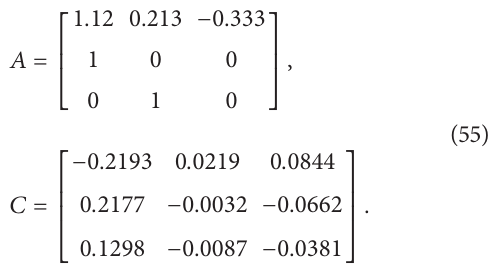
𝐻 𝛾 = 3 . 0613 for satisfying all discrete time- ∞ performance varying delays. Figure 1 shows that the system state 𝑥(𝑘) converges to zero, where the initial condition is set to be 𝑥( 0 ) = [− 1 , 0 . 4 , 1 ]